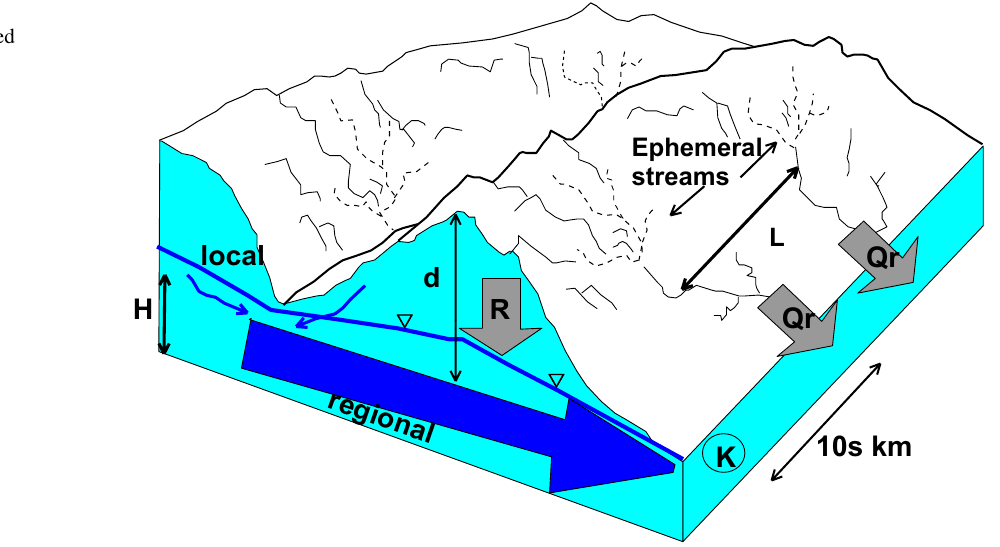
Fig. 2 A schematic diagram depicting a recharge-controlled water table ( Modified from Gleeson et al.